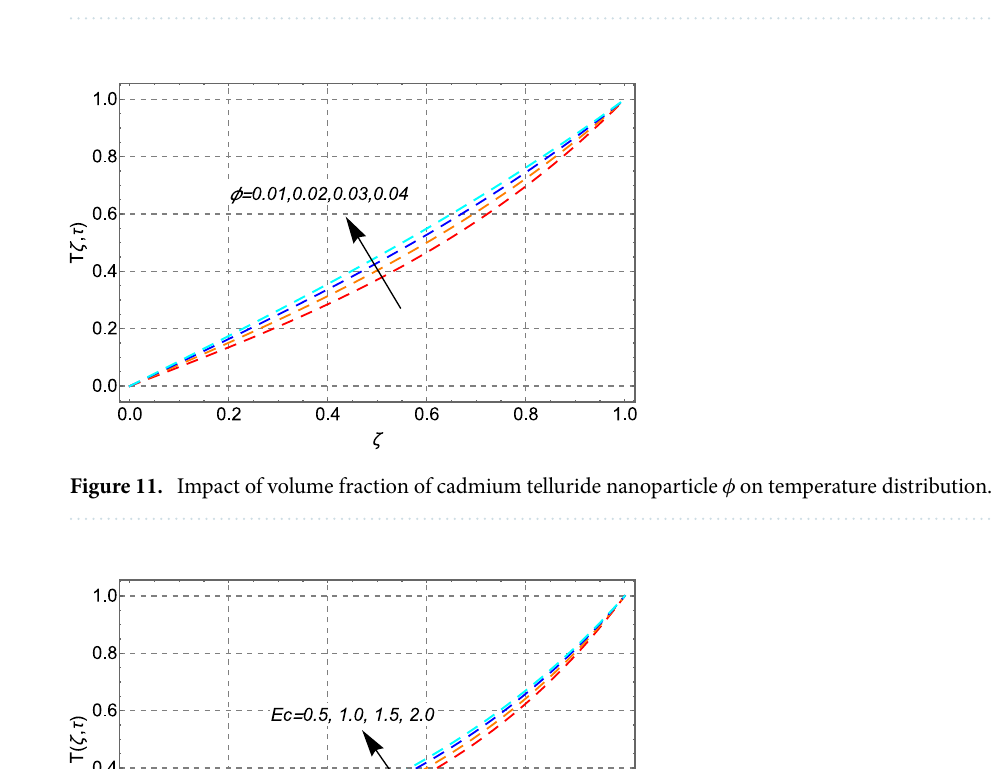
Figure 10. Comparison of temperature distribution for fractal-fractional, fractal, fractional and classical order.